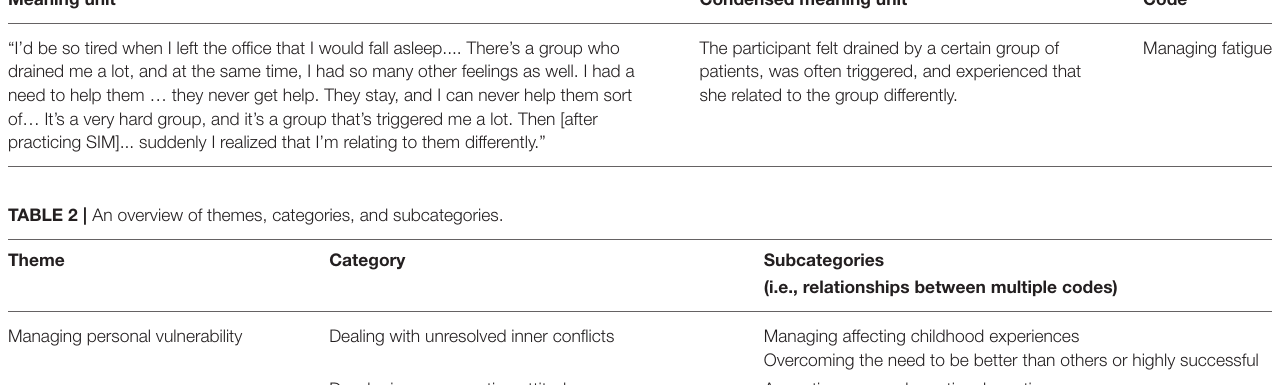
TABLE 1 | Example of a meaning unit, condensed meaning unit, and code. Meaning unit